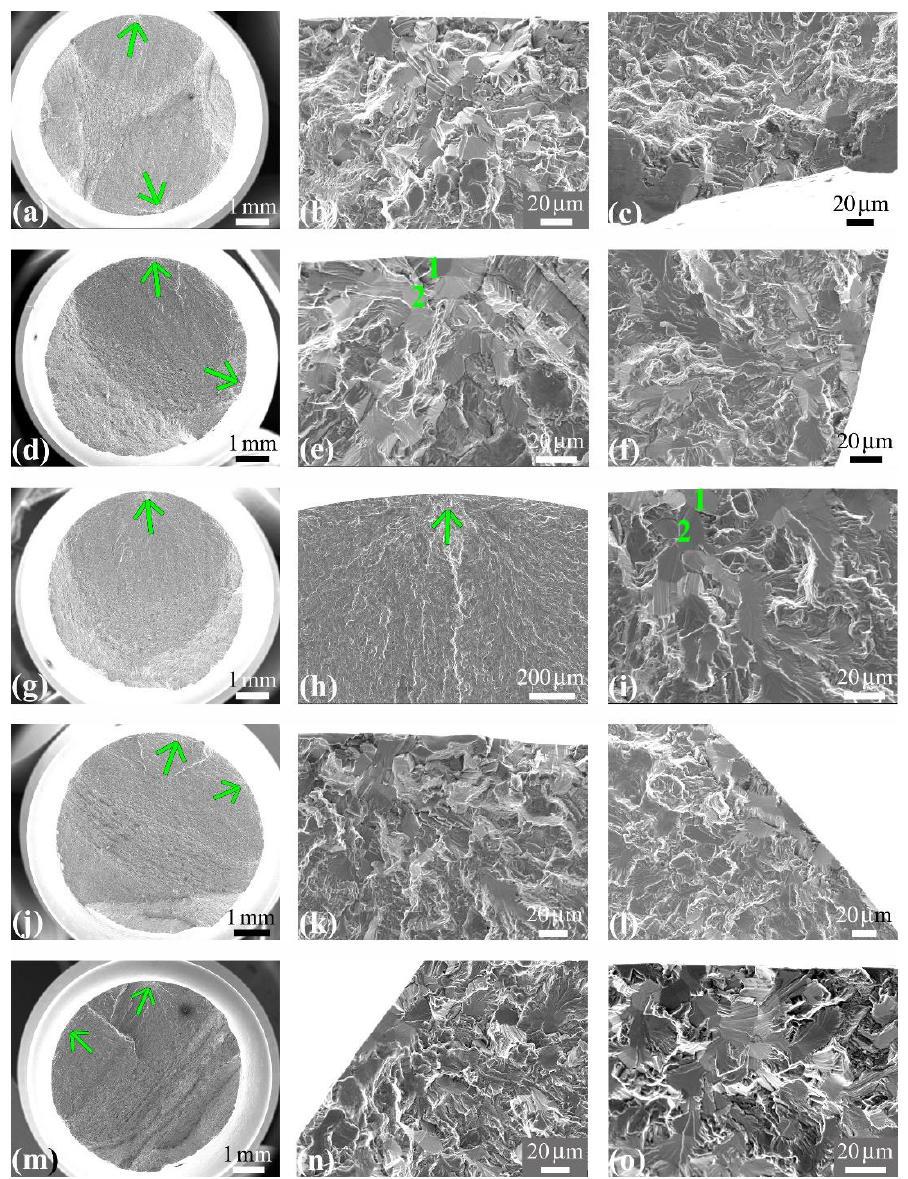
Figure 9. Morphologies of fracture surface of notched specimens. ( a – c ): conventional fatigue testing at nominal maximum stress σ max = 656 MPa and N f = 43,046 cycles; ( b , c ) are magnified images of the regions where the up and down arrows point to in ( a ), respectively. ( d – f ): Conventional fatigue testing at nominal maximum stress σ max = 700 MPa and N f = 30,815 cycles; ( e , f ) are magnified images of the regions where the up and right arrows point to in ( d ), respectively; The numbers 1 and 2 denote the locations exhibiting facet feature. ( g – i ): Dwell fatigue testing at nominal maximum stress σ max = 656 MPa, d t ,max = 2 s and N f = 35,989 cycles; ( h , i ) are magnified images of the regions that the arrow points to in ( g , h ), respectively; The numbers 1 and 2 denote the locations exhibiting facet feature. ( j – l ): Dwell fatigue test at nominal maximum stress σ max = 700 MPa, d t ,max = 2 s and N f = 28,701 cycles; ( k , l ) are magnified images of the regions where the top and right arrows point to in ( j ), respectively. ( m – o ): Dwell fatigue testing at nominal maximum stress σ max = 700 MPa, d t ,max = 20 s and N f = 27,441 cycles; ( n , o ) are magnified images of the regions where the left and up arrows point to in ( m ),